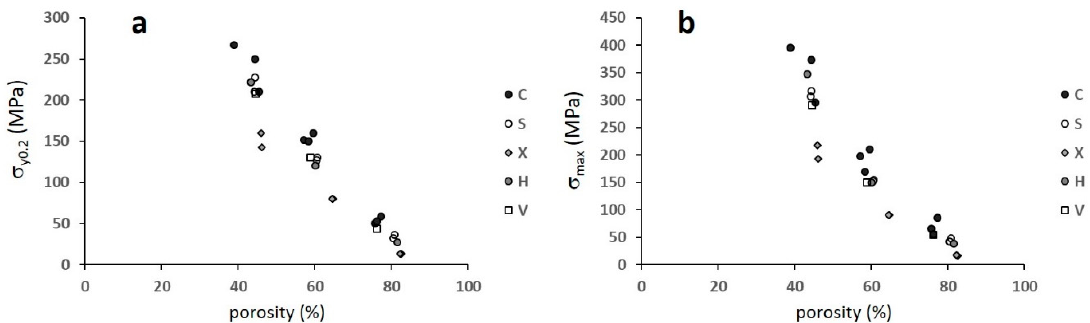
Figure 12. ( a ) The yield strength and ( b ) the maximum compressive strength versus porosity. The capital letters refer to structures.